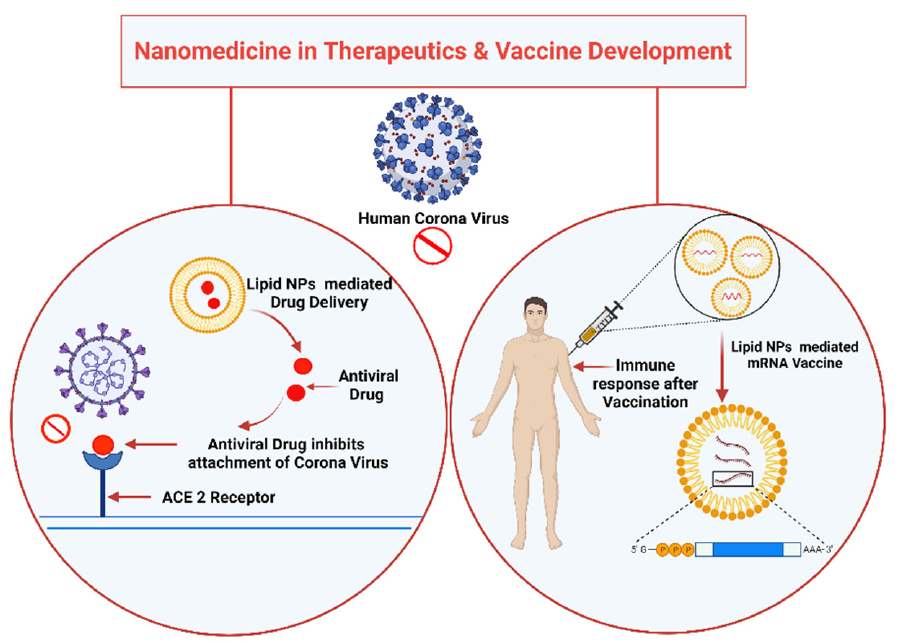
Figure 4. Nanomedicine in Therapeutics and Vaccine Development.